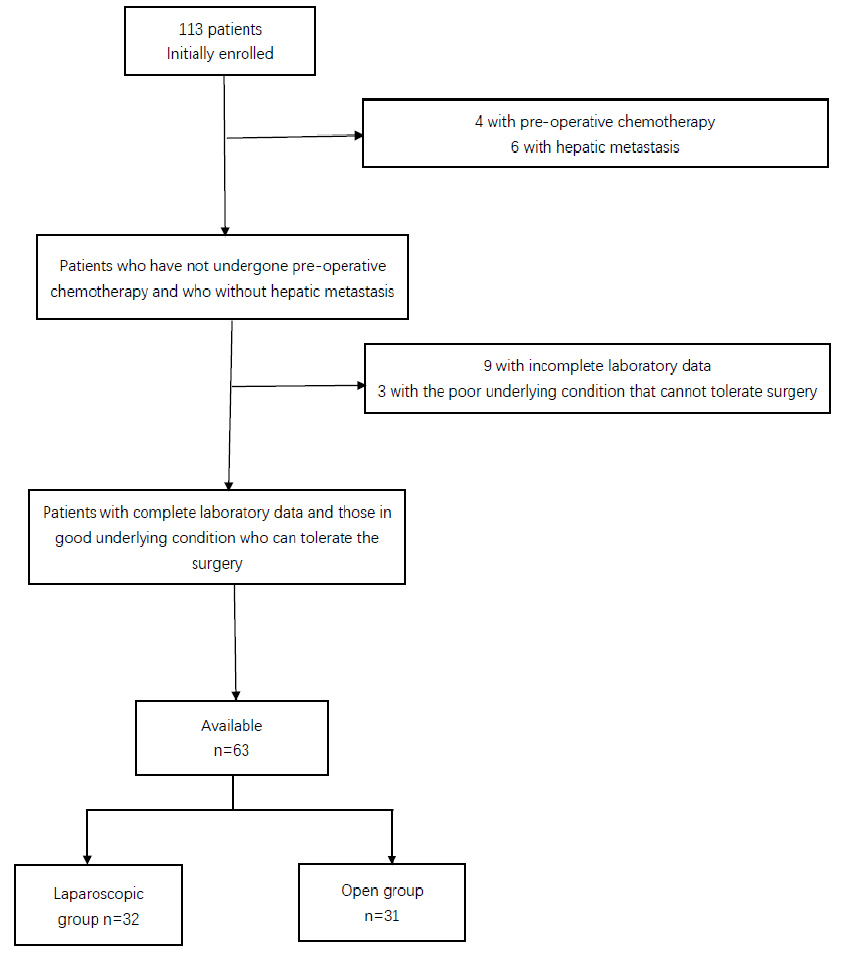
Figure 1. Filtering process of patient data from the initial inclusion of patients.